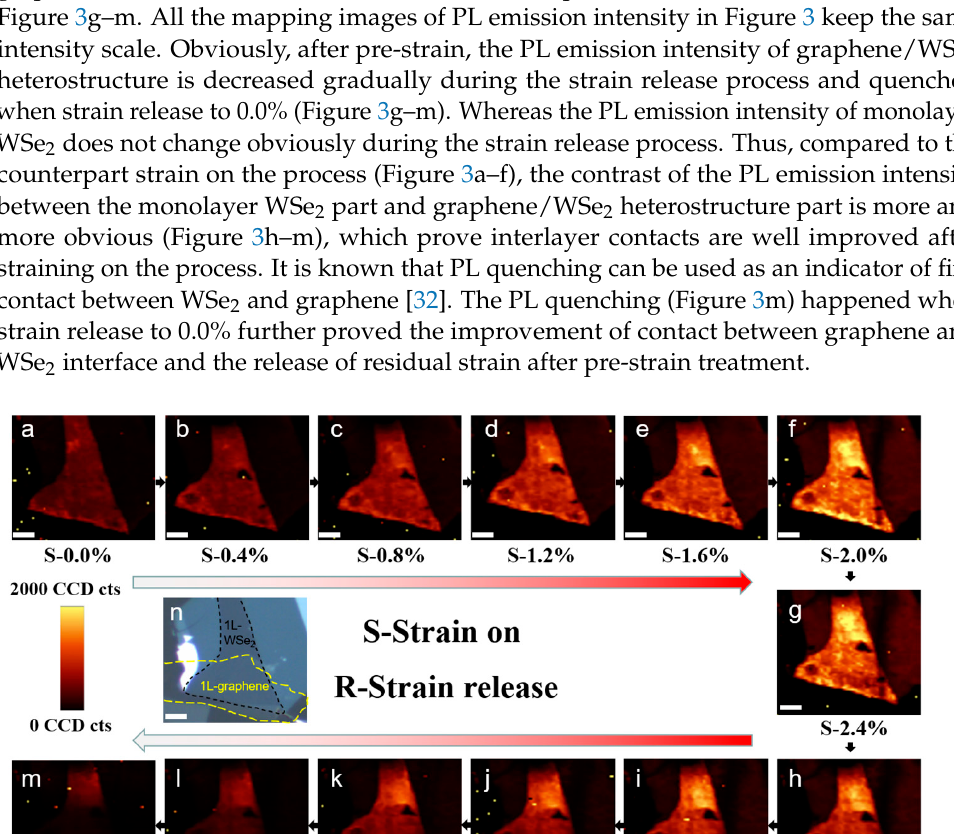
Figure 4. The fitted PL emission energies of A and A T peaks in 1L-WSe 2 ( a ) and A and A T peaks in 1L-WS 2 ( b ) with the increasing strain from 0 to 1.6% for the first strain on (pre-strain) and the second strain on process. Insert is the optical image of the 1L WSe 2 ( a ) and 1L-WS 2 ( b ) (yellow marked area). The fitted PL emission energies of A and A T peaks of bottom 1L-WSe 2 in WSe 2 /WS 2 heterostructure ( c ) and A and A T peaks of upper 1L-WS 2 in MoSe 2 /WS 2 heterostructure ( d ) with the increasing strain from 0 to 1.6% for the first strain on (pre-strain) and the second strain on process. Insert is the optical image of the WSe 2 /WS 2 ( c ) (yellow frame 1l-WSe 2 and white frame 1L-WS 2 ) and MoSe 2 /WS 2 (yellow frame 1l-MoSe 2 and white frame 1L-WS 2 ) ( d ) heterostructure. The scale bar is 4 μ m in all figures.